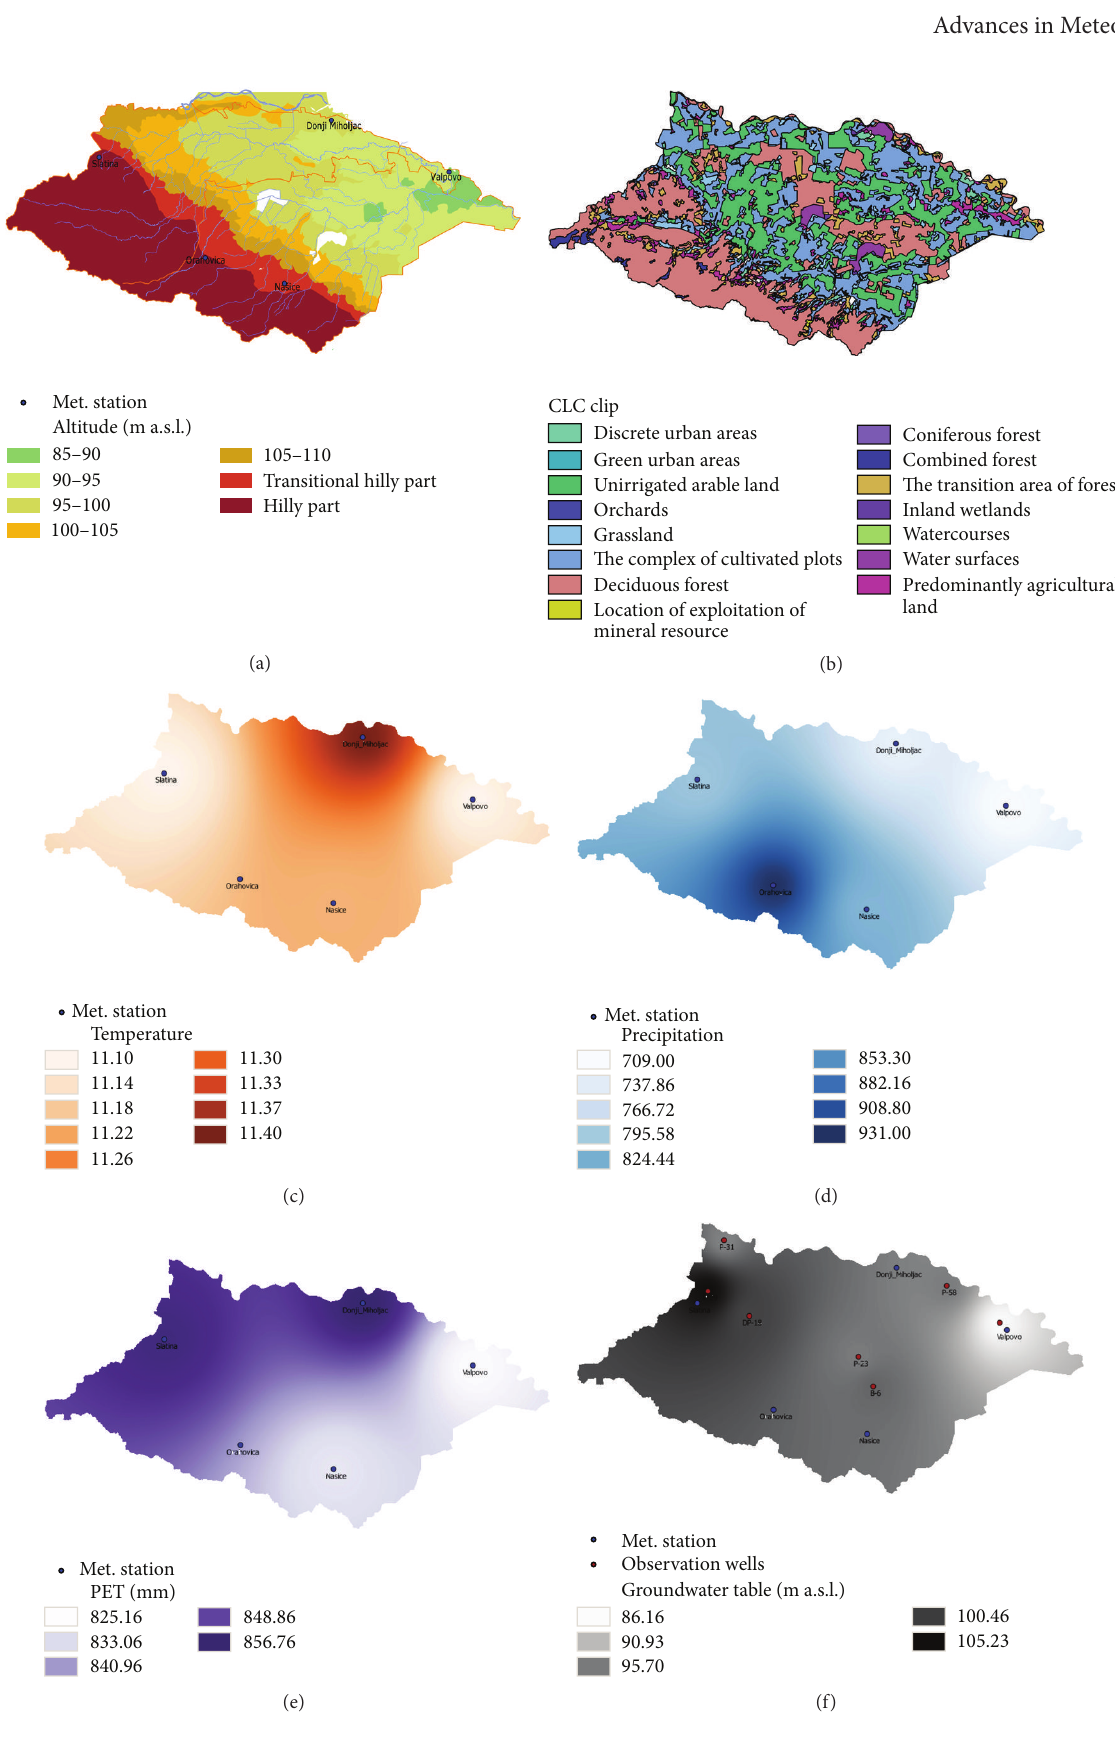
Figure 2: (a) Altitude map of the catchment area, (b) land use map, (c) mean air temperature distribution, (d) annual precipitation distribution, (e) annual potential evapotranspiration distribution, and (f) mean groundwater